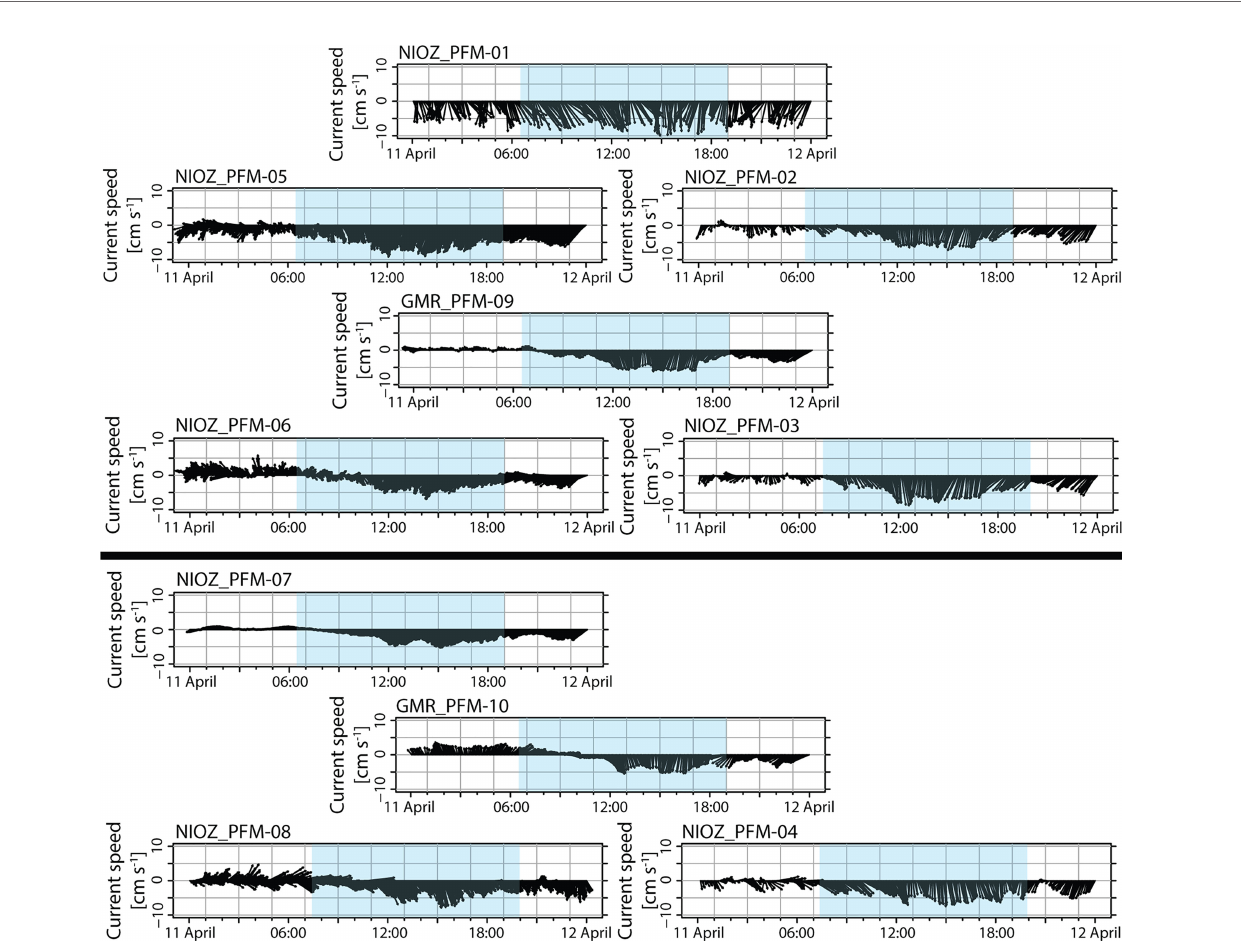
FIGURE 6 | Time series of current speed and direction recorded on the 11 th of April by the Nortek Aquadopp pro fi lers (bin 1 at 1.25 mab, NIOZ_PFM-02 to -08) and the RDI Workhorse ADCPs (bin 7 at 19 mab, GMR_PFM-09 and -10, and bin 3 at 0.7 mab, NIOZ_PFM-01) located north and south of the dredge tracks. The blue overlay indicates the time interval during which the dredging took place. The arrangement of the time series graphs corresponds with the geographical arrangement of the sensor platforms north and south of the dredge tracks (black line through the